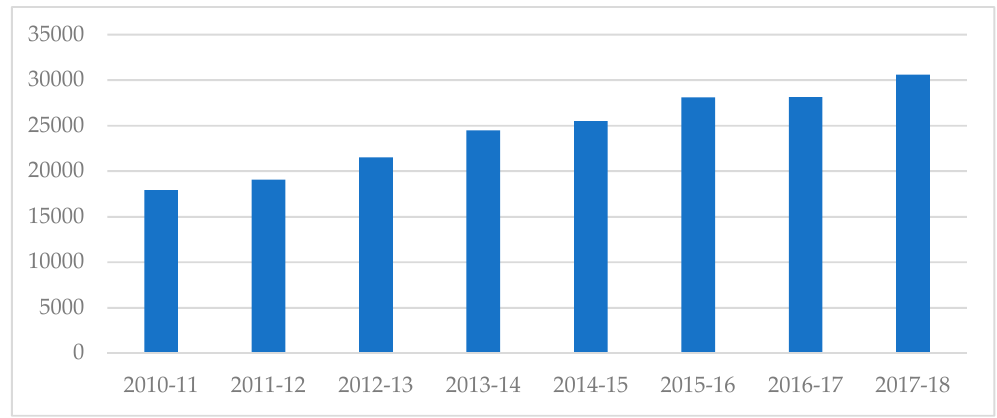
Figure 3. Yearly export of readymade garments (RMGs) in millions of United States dollars (USD) [6].